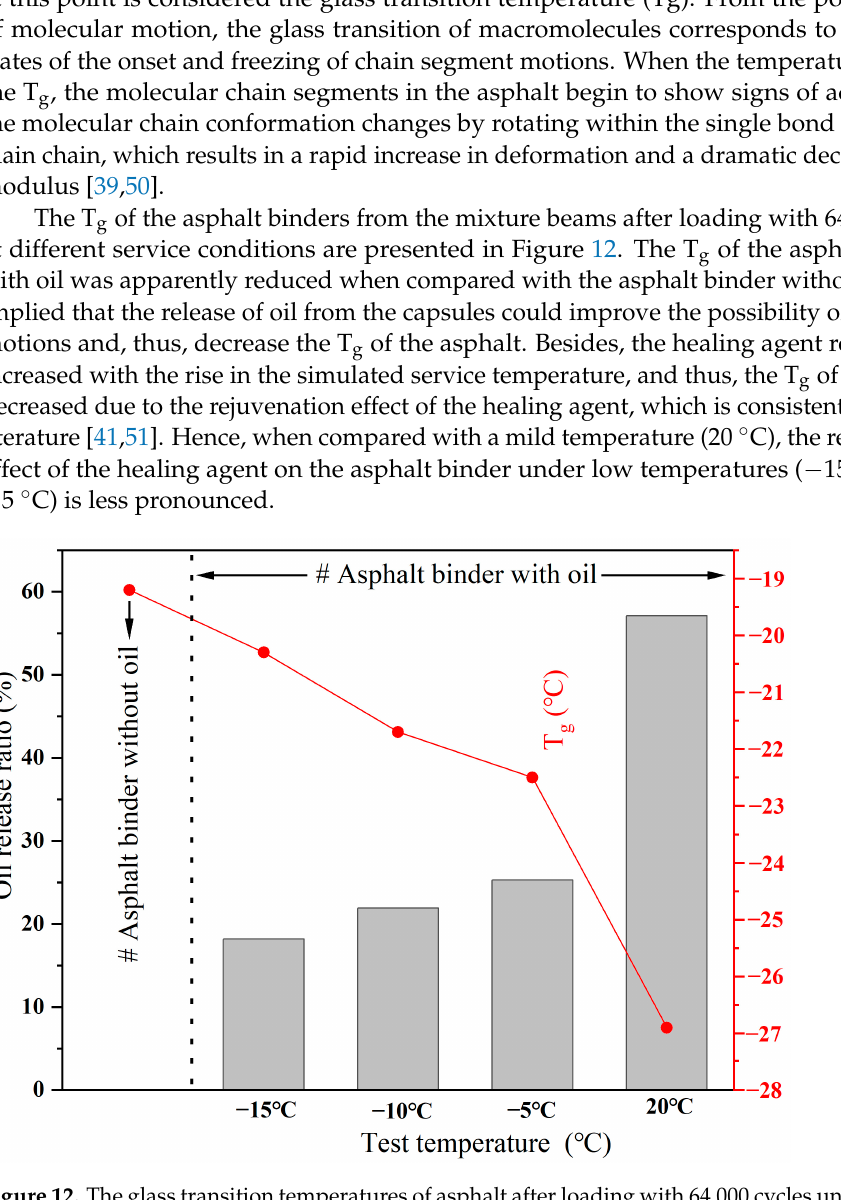
Figure 12. The glass transition temperatures of asphalt after loading with 64,000 cycles under dif ‐ ferent service temperatures. service